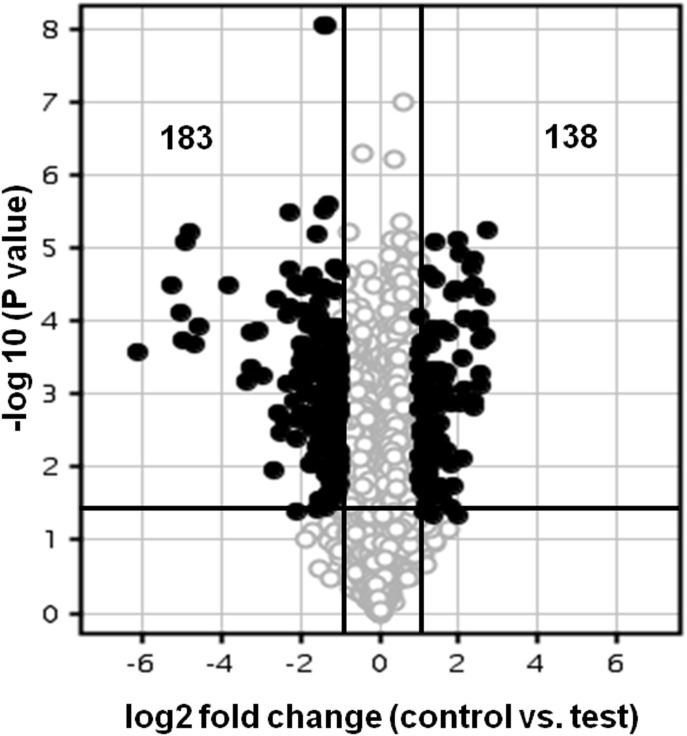
DNA microarray analysis of long-term stationary phase-induced gene expression in E. coli grown in LB broth plus glycerol.The Volcano plot depicts gene expression in LSP E. coli culture at 0.8 OD (OD600nm) cultured in LB broth compared to the freshly grown SP E. coli culture l. Genes that are represented on the right side of the volcano-axis are up-regulated and those that are on left side of the axis are down-regulated. Out of the 4377 genes (O) analysed, 138 genes were up-regulated (•) and 183 were down-regulated (•). Only those genes that showed more than 2.0 fold change in expression and a P value <0.05 were identified as either up- or down-regulated. The X-axis represents the log2 fold change and the dark vertical lines represent cut-offs at 2.0 fold decrease and increase. The y-axis represents the –log10 p-values and the dark horizontal line indicates a p value cut-off of 0.05.